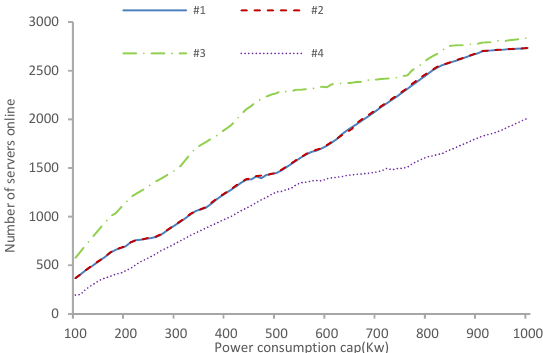
Figure 6. Number of servers online for different data centers.